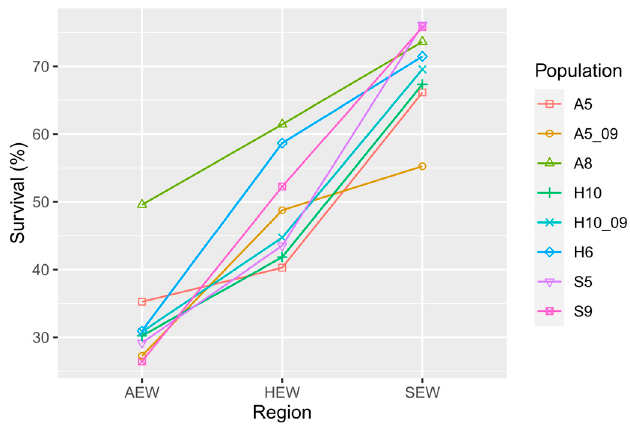
Figure 5. Interaction plot of mean plant survival in 2015 of the different populations in the three study regions. (Populations from the SEW region: S5 and S9; from HEW: H10, H10_09, and H6; from AEW: A5, A5_09, and A8. For the populations H10 and A5, seeds from 2009 were also available for raising seedlings and are named H10_09 and A5_09, respectively).